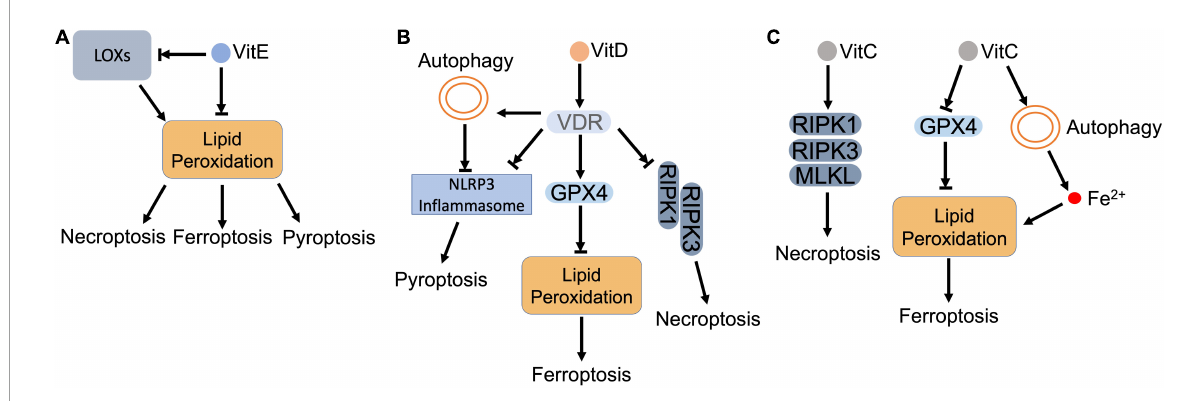
FIGURE5 Vitamins and regulated necrosis. (A) Vitamin E. Vitamin E (VitE) attenuates regulated necrosis through downregulating the intracellular ROS. As lipophilic antioxidants, VitE can directly remove the lipid peroxides that accumulate in the cell. Meanwhile, VitE inhibits the activity of LOXs, which also blocks the lipid peroxidation. (B) Vitamin D. Vitamin D (VitD) activates vitamin D receptor (VDR), which (i) inhibits the formation of necrosome to block necroptosis; (ii) upregulates the expression of GPX4 to inhibit lipid peroxidation and resultant ferroptosis; (iii) inactivates inflammasome directly or via autophagy to inhibit pyroptosis. (C) Vitamin C. Vitamin C (VitC) upregulates the expression of RIPK1, RIPK3, and MLKL, which triggers necroptosis. In addition, VitC triggers lipid peroxidation by (i) inactivating GPX4: (ii) increasing the intracellular ferrous iron. The accumulated lipid peroxides lead to